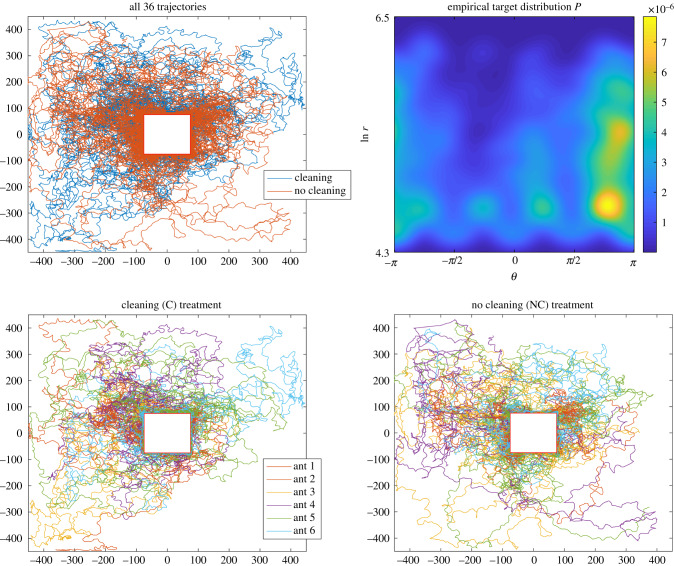
The ants’ exploration trajectories for the two treatments and empirical target distribution P. All trajectories are shown in the top-left pane, marked by treatment, while trajectories are shown by treatment and ant order in the bottom panes (three ants for each order in the sequence).